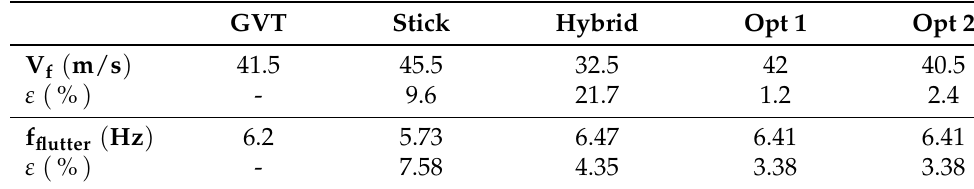
Table 8. Flutter velocity and flutter frequency committed error comparison.